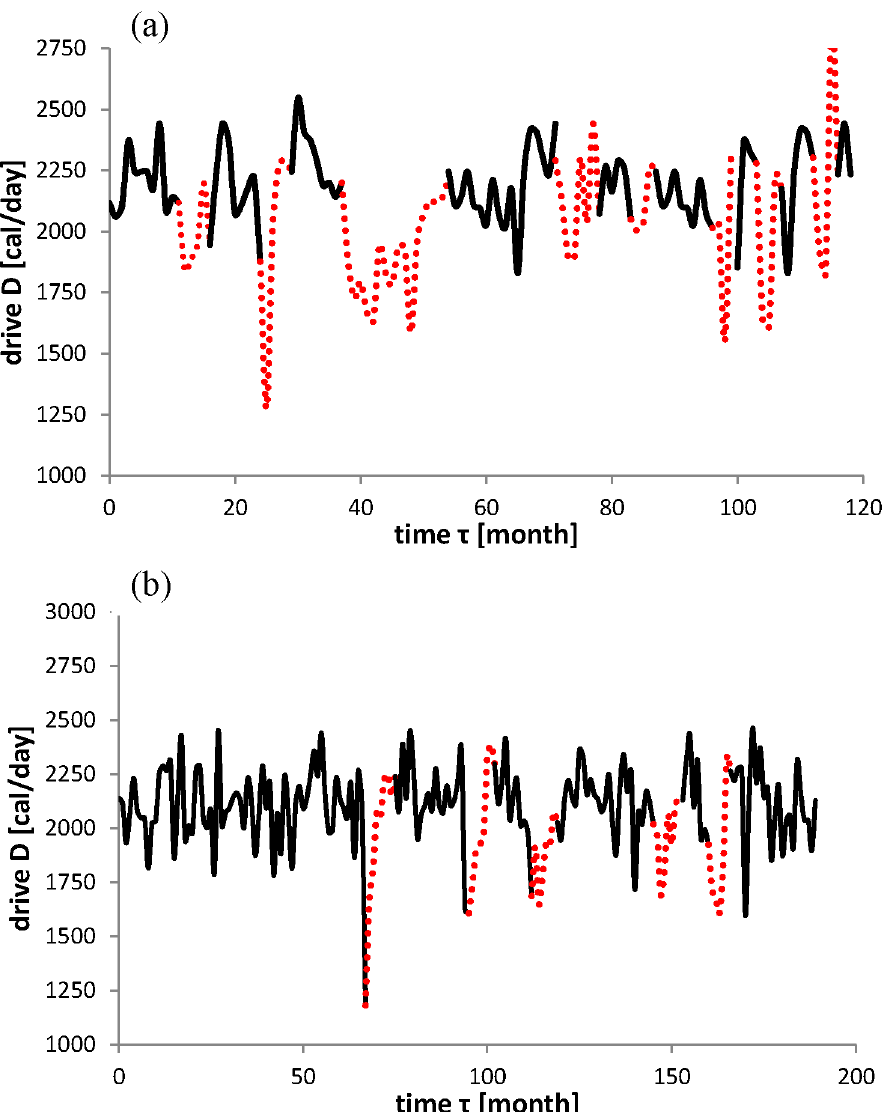
Figure 3. Reconstruction of the drive D (solid line) containing dietary periods (dotted). (a) Subject A. (b) Subject B.